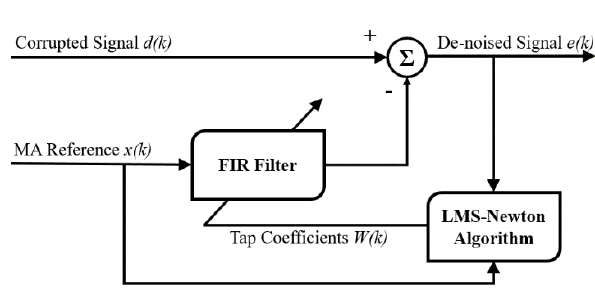
Table 1. Results of HR AAE with and without the cascaded adaptive noise cancellation (ANC)